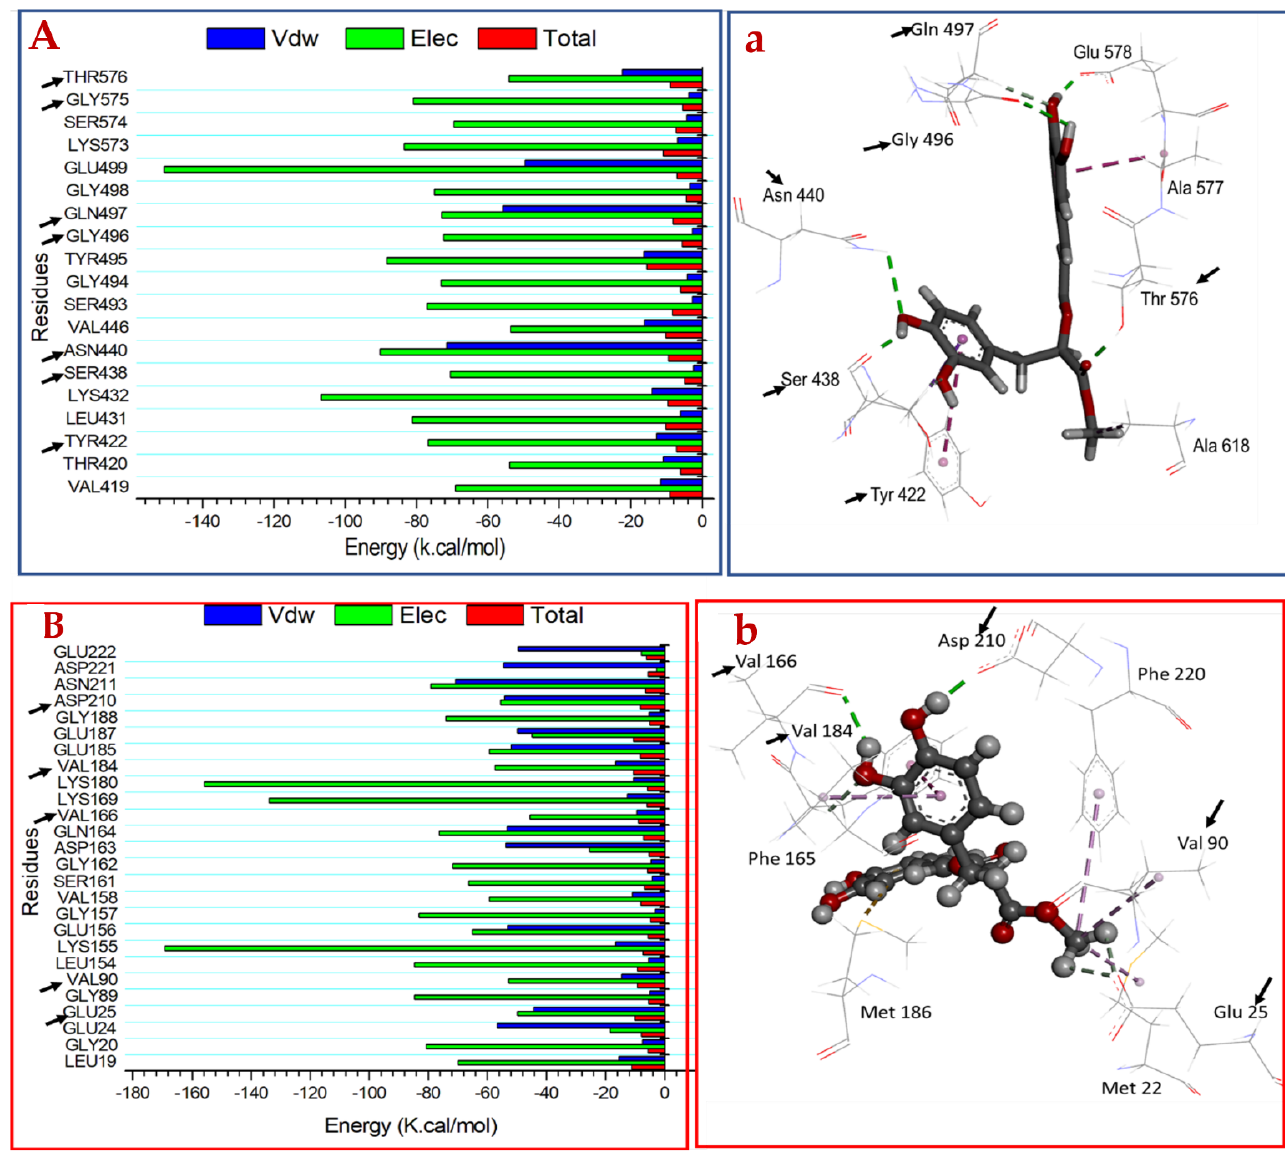
Figure 6. Per-residue decomposition plots showing the energy contributions to the binding and stabi- lization of MR at the catalytic active site of ( A ) peptidoglycan transpeptidases and ( B ) H. pylori urease receptor. Corresponding inter-molecular interactions are shown in ( a ) peptidoglycan transpeptidases and ( b ) H. pylori